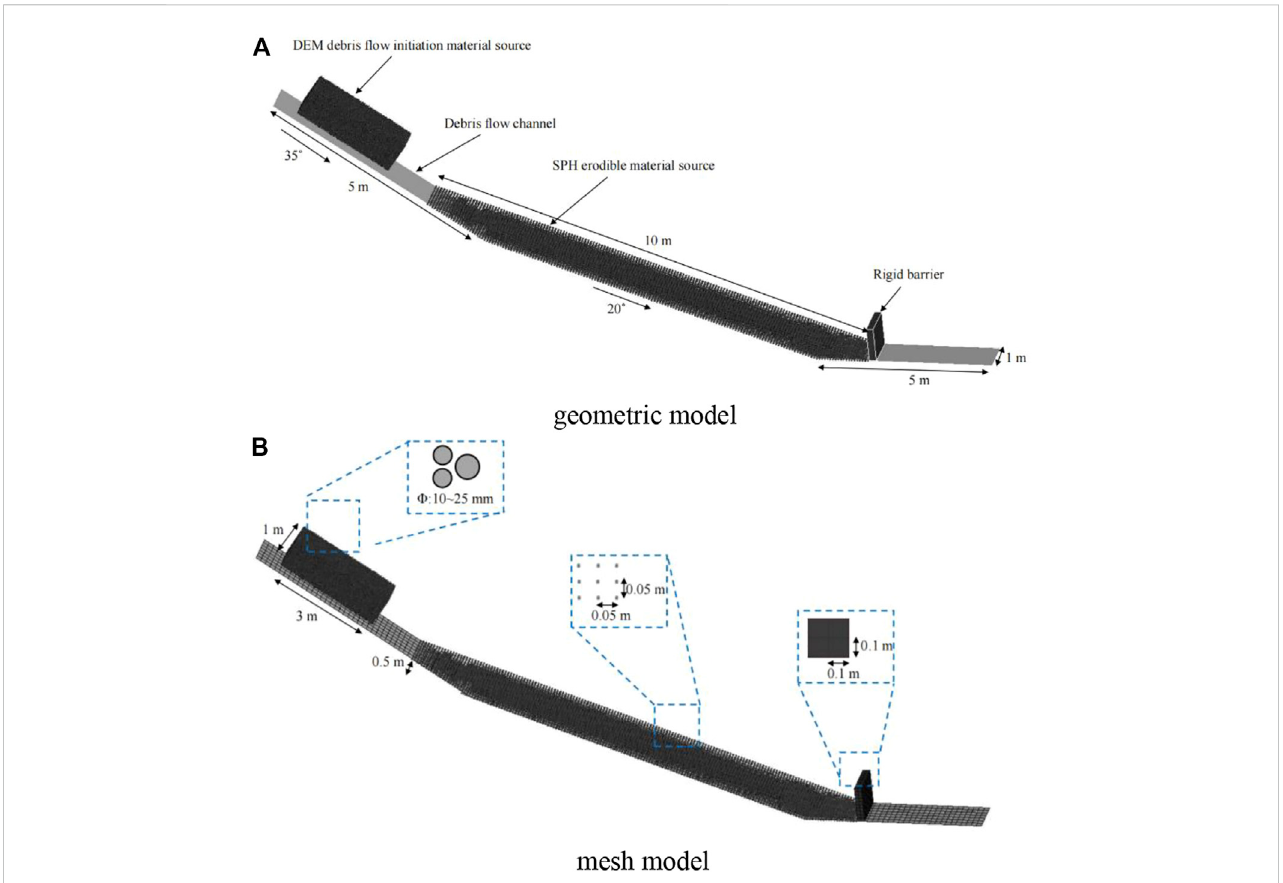
FIGURE 12 Debris fl ow and barrier model considering the erosion-entrainment process (A) geometric model (B) mesh model.